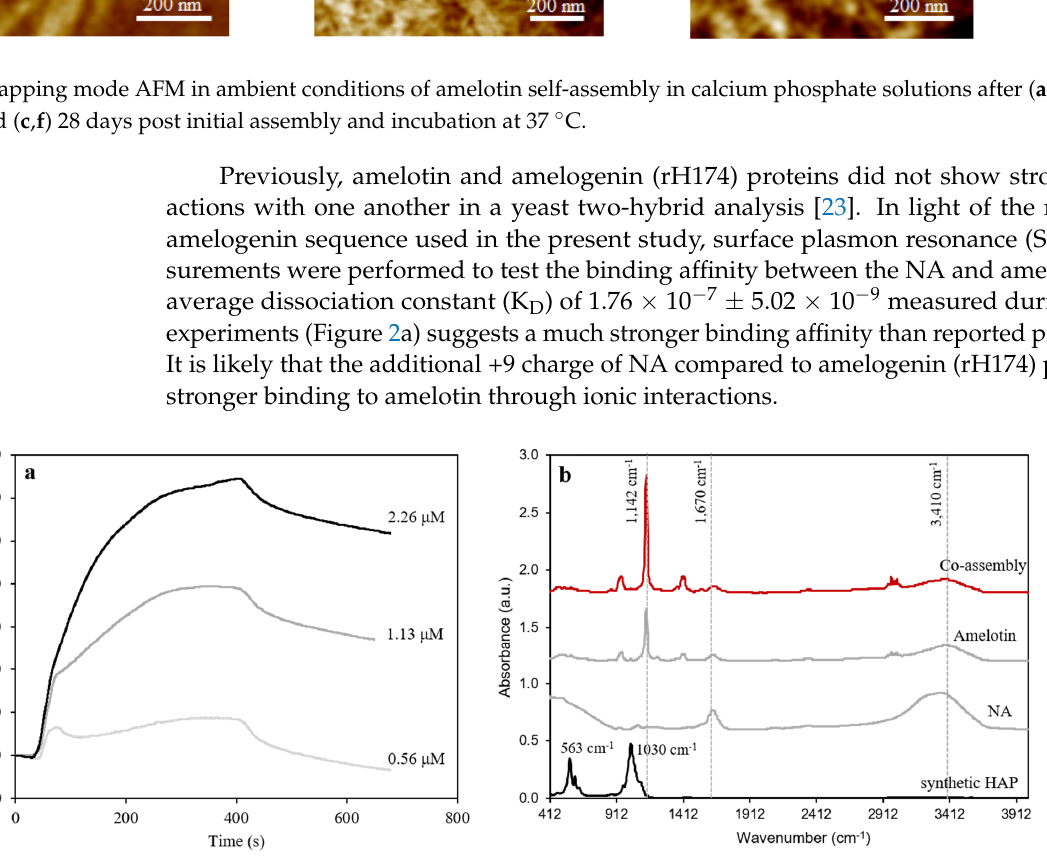
Figure 2. ( a ) SPR characterization of 2.26 µ M amelotin on a NTA chip, with NA protein as analyte with a concentration of 2.26 (BMax 129.56 ◦ ), 1.13 (BMax 415.89 ◦ ) and, 0.56 µ M (BMax 645.37 ◦ ). The dissociation constant was calculated to be 1.25 × 10 − 7 ± 4.34 × 10 − 9 , 1.61 × 10 − 7 ± 2.43 × 10 − 9 and 1.75 × 10 − 7 ± 8.29 × 10 − 9 , respectively, as described in the Supplementary Materials. ( b ) FTIR examination of NA protein, amelotin, co-assembly and synthetic hydroxyapatite crystals. The main mineral observed in the co-assembly samples was hydroxyapatite.